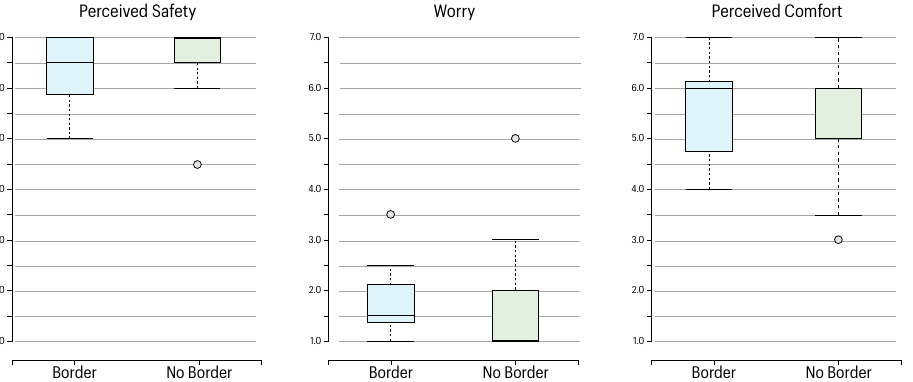
Figure 4. Results on perceived safety ( left ), comfort ( right ), and worry about touching the car interior (middle) for the No Border and Border conditions. The perceived levels of safety and comfort were high and the fear of touching the car interior was limited in both